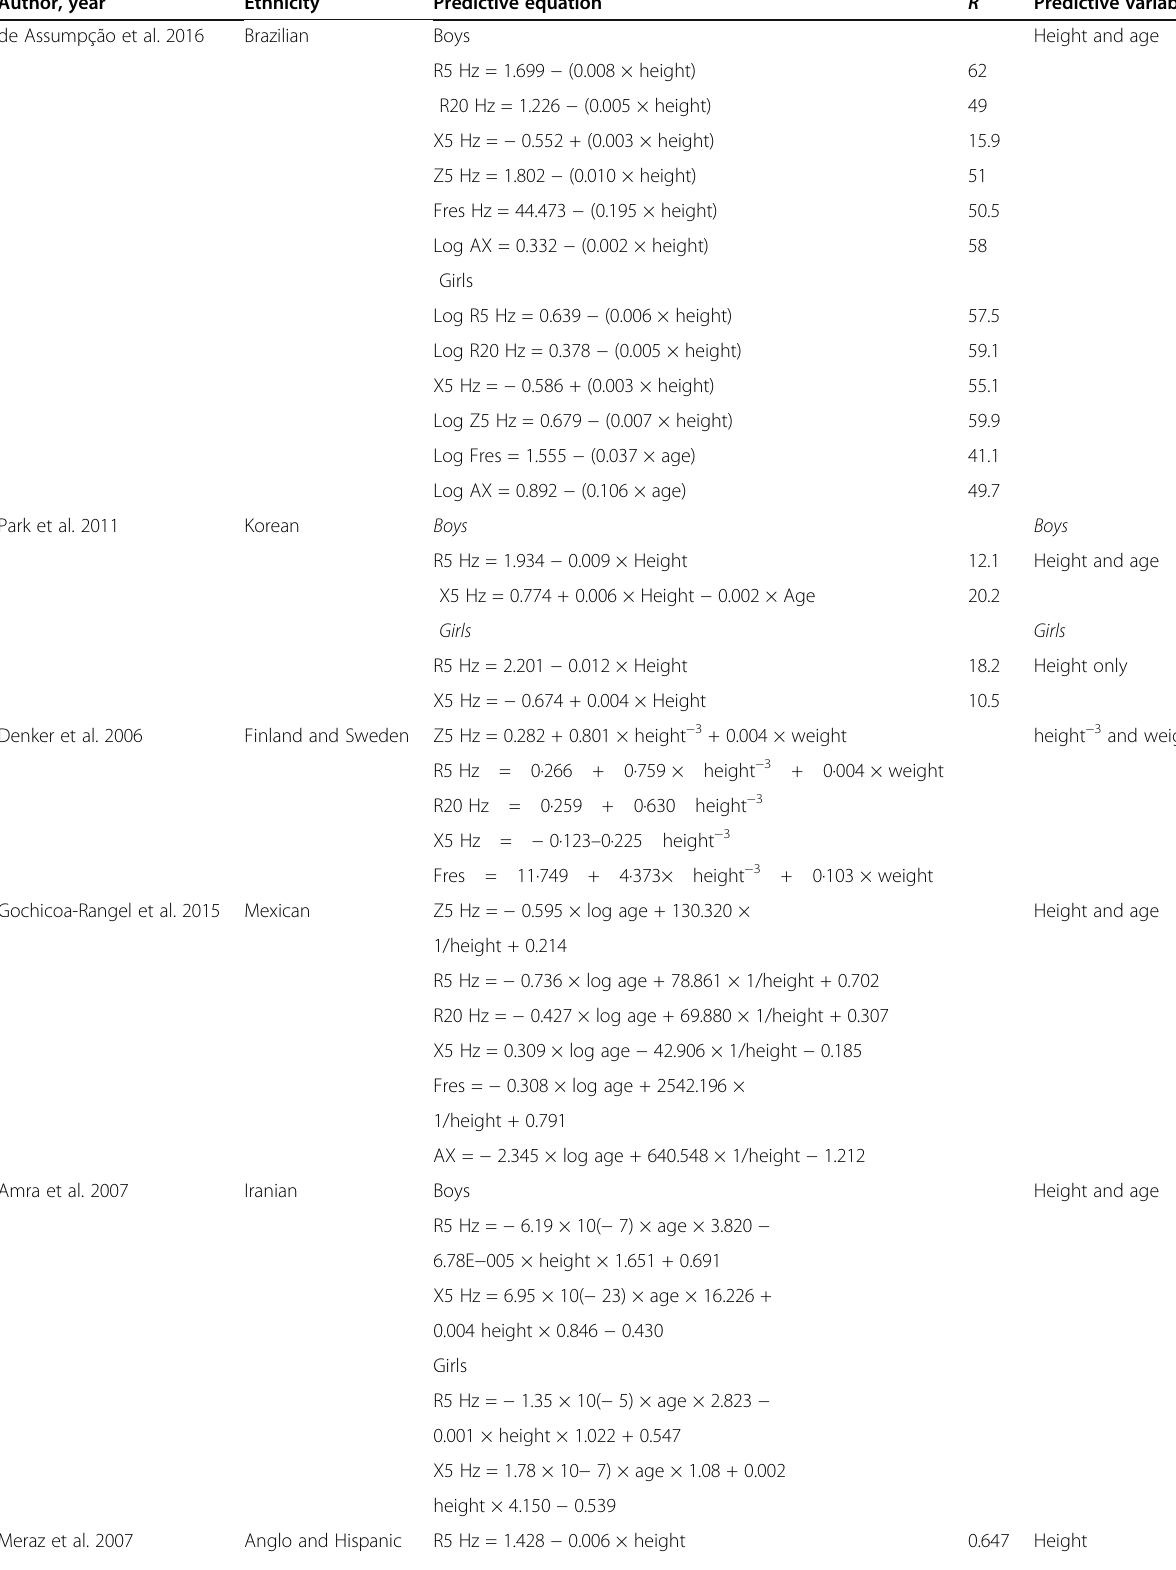
Table 6 Summary of the predictive equation of impulse oscillometry in different ethnicities Author,